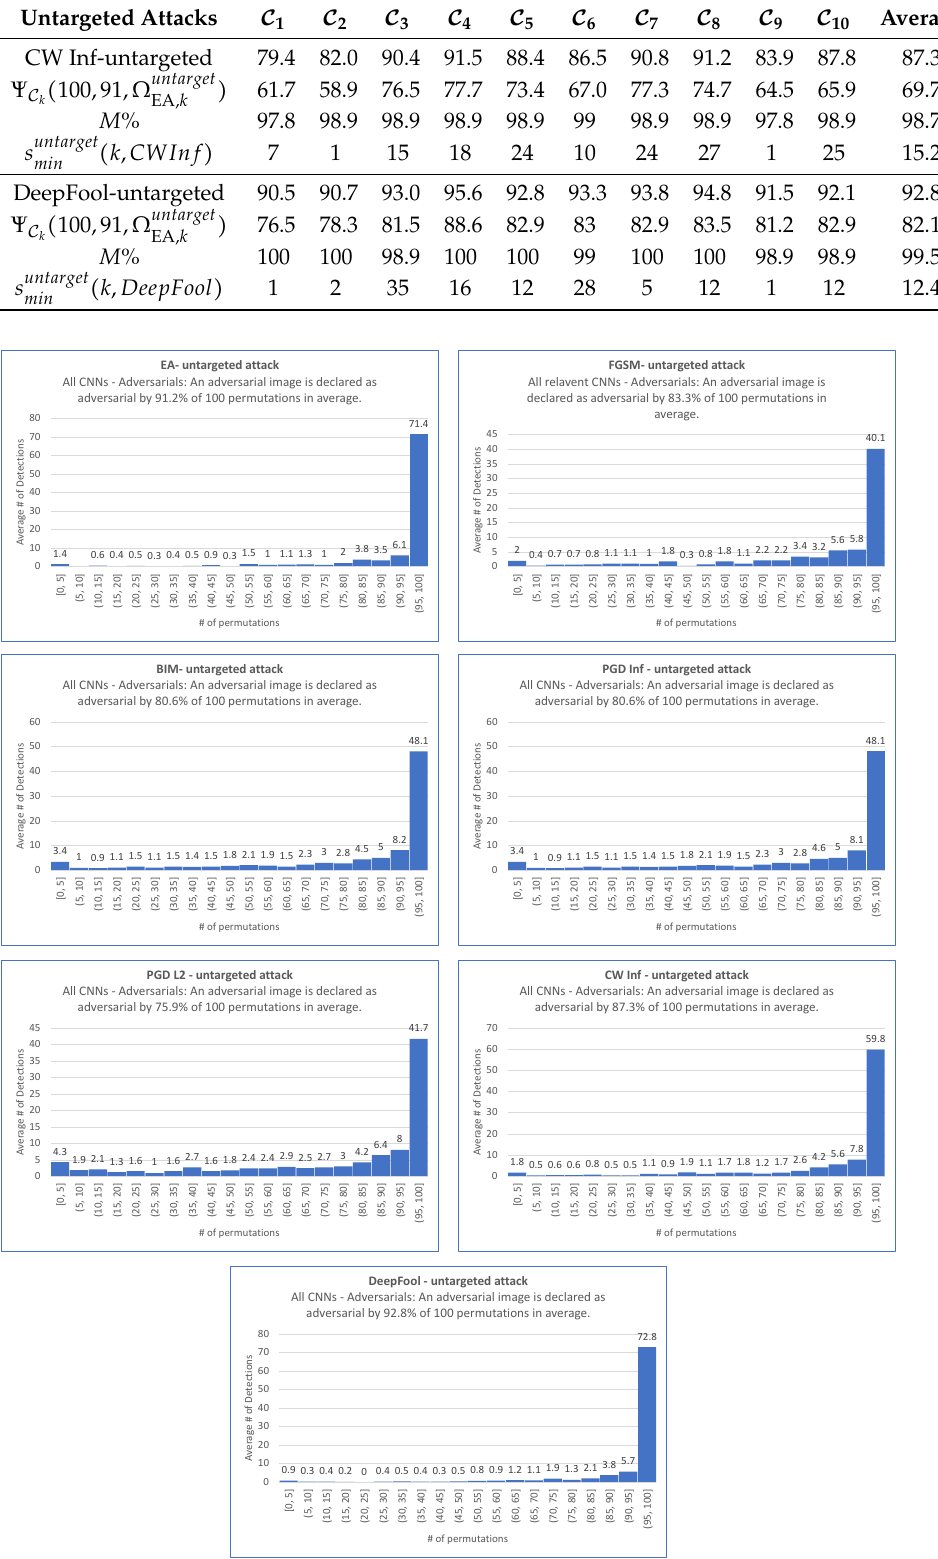
Figure 4. Average outcome over all relevant CNNs of ShuffleDetect performed with 100 permutations on the adversarial images created for the untargeted scenario by EA, FGSM, BIM, PGD Inf, PGD L2, CW Inf, and